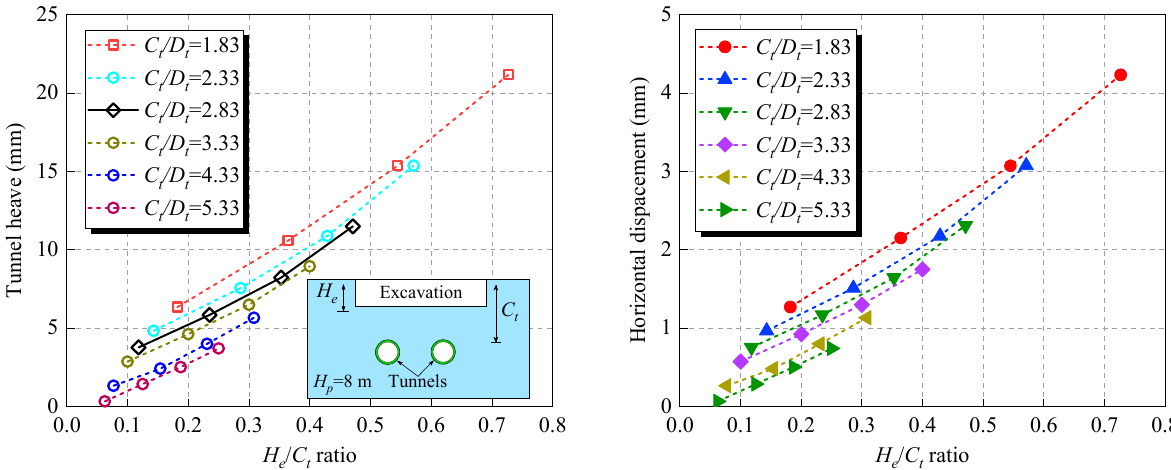
Figure 18. Influence of unloading ratio on tunnel displacement.